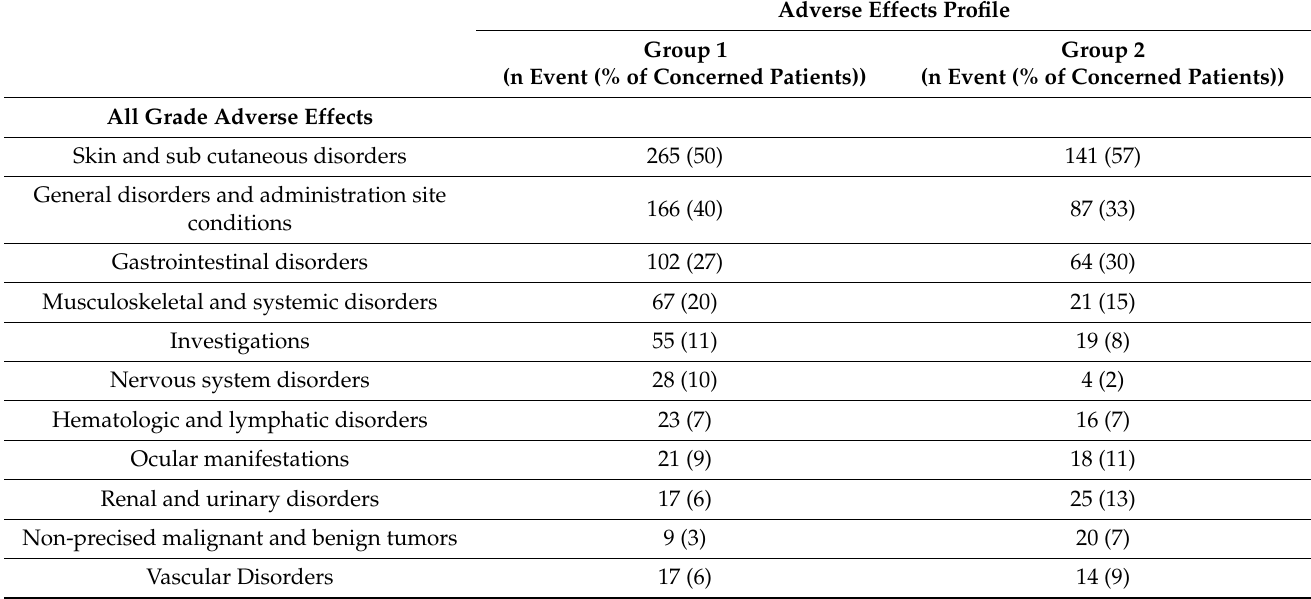
Table 3. All grade adverse effects due to BRAF and MEK